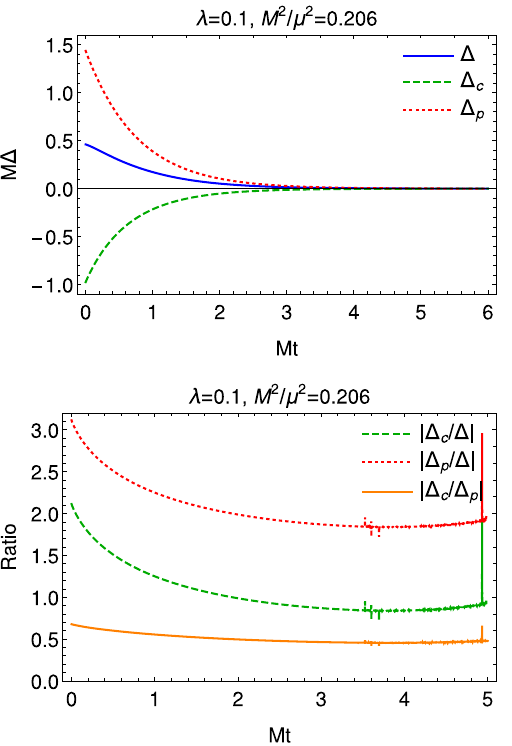
Fig. 23 The same plots for the gluon Schwinger function in the Euclidean region as those in Fig. 19 for the choice of parameters with a smaller coupling constant, λ = 0 . 1, M 2 /μ 2 = 0 .